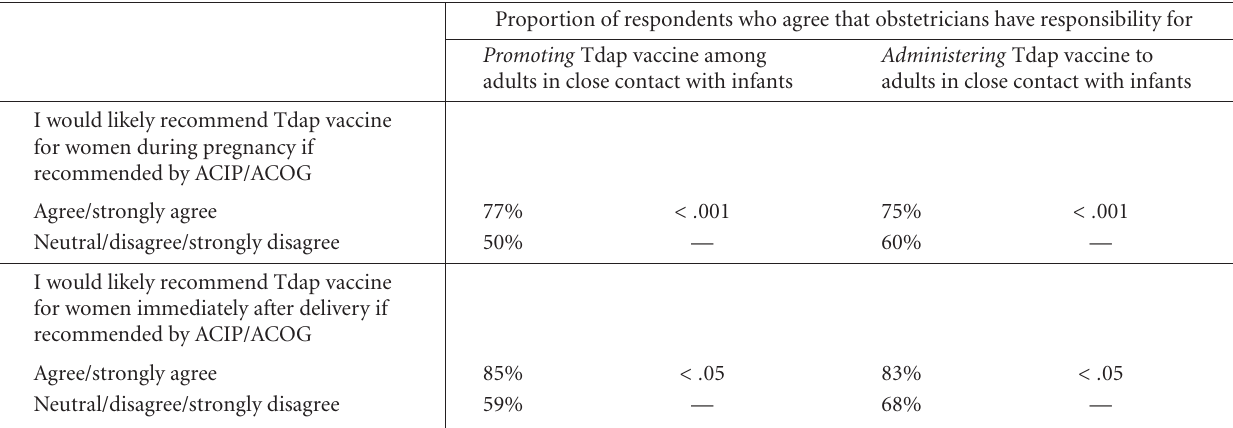
Table 1: Di ff erences in obstetricians’ perceived responsibility for promoting or administering Tdap vaccine to adults in close contact with infants ( P value compares responses of agree/strongly agree versus neutral/disagree/strongly